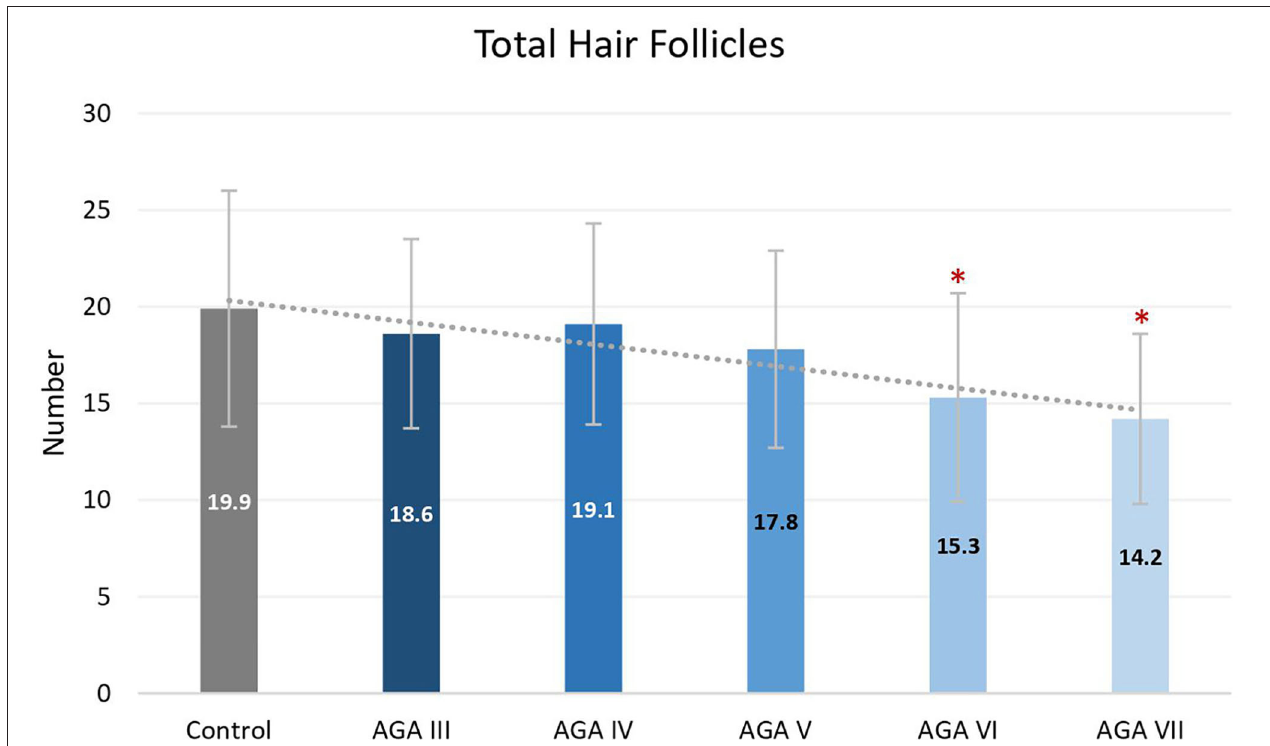
FIGURE 1 | Total hair follicles between controls and patient subgroups with different disease severity of androgenetic alopecia (AGA) . * P < 0.05 when compared to the control group.